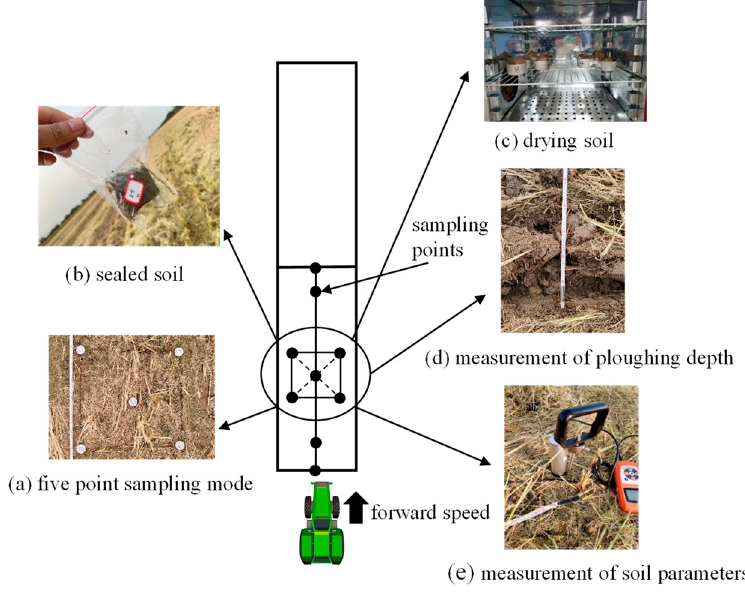
Figure 4. Diagram of the soil parameter acquisition process.